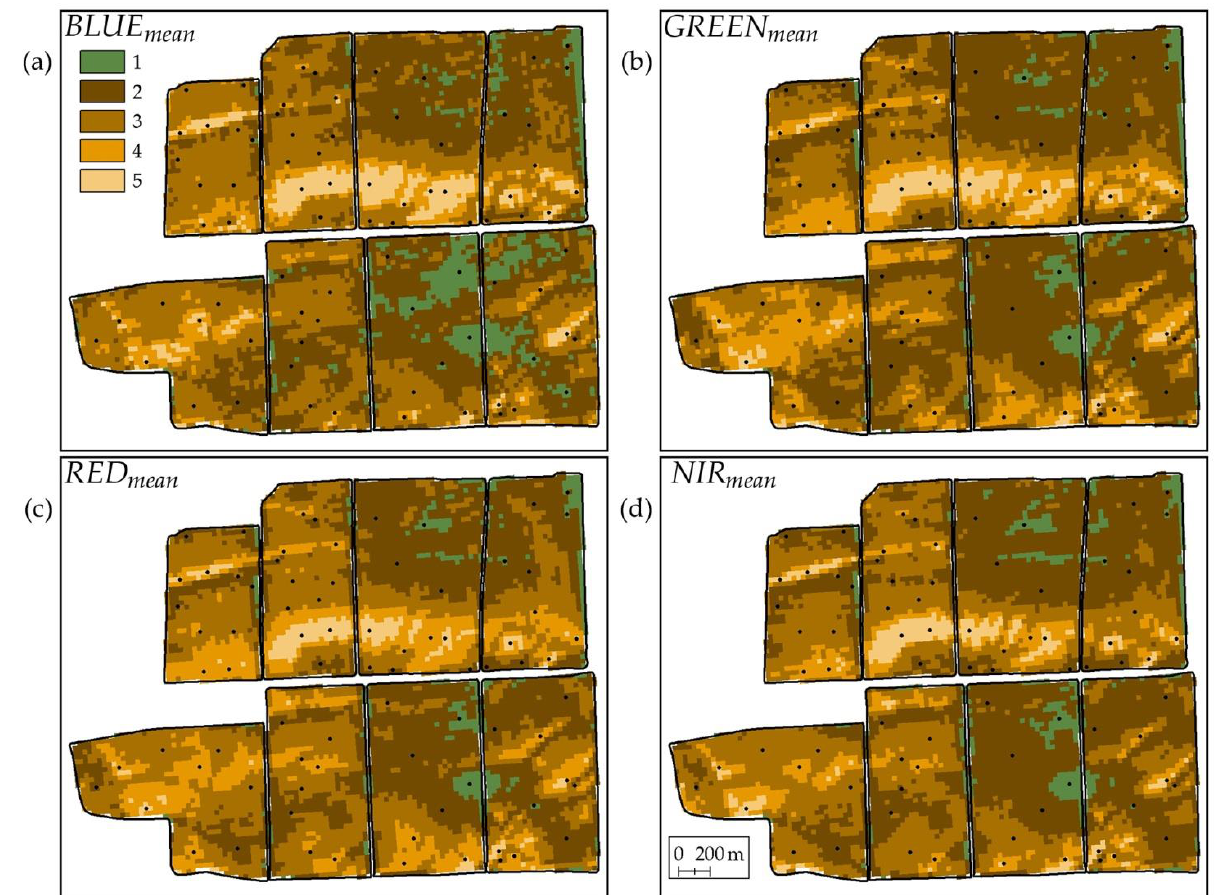
Figure 8. Soil maps based on classification of BAND mean values (soils are: 1 — meadow-chestnut, 2 — dark chestnut, 3 — dark chestnut slightly eroded, 4 — dark chestnut medium eroded, 5 — dark chestnut strongly eroded).